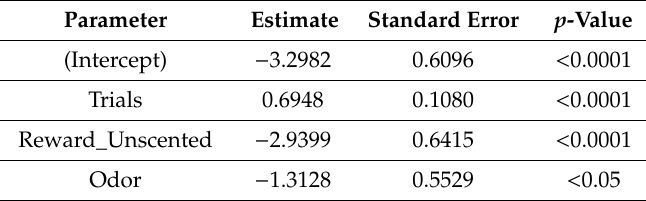
Table 2. Comparative significance by levels of the main factors in the fitted model 1 (generalized linear mixed model (GLMM)), explaining the olfactory conditioned response PER in day 1 of the stingless bee Melipona